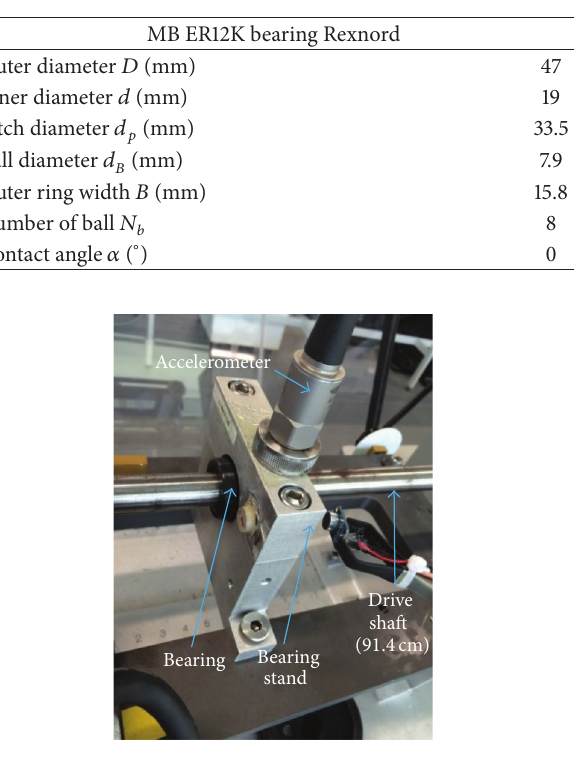
Figure 7: Experimental set-up with a faulty